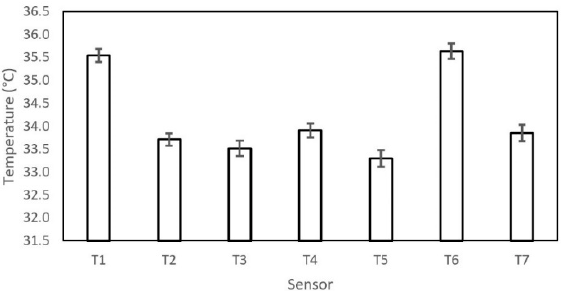
Figure 2. Spatial variation in temperature from 2:00 p.m. to 2:30 p.m.